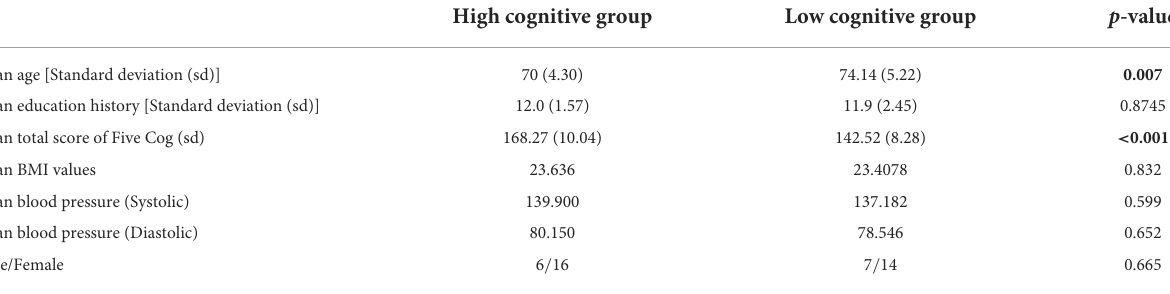
TABLE 1 Basic composition of the participants in high and low cognitive functioning groups based on Five-Cognitive Functions (Five-Cog) scores. High cognitive group Low cognitive group p -value